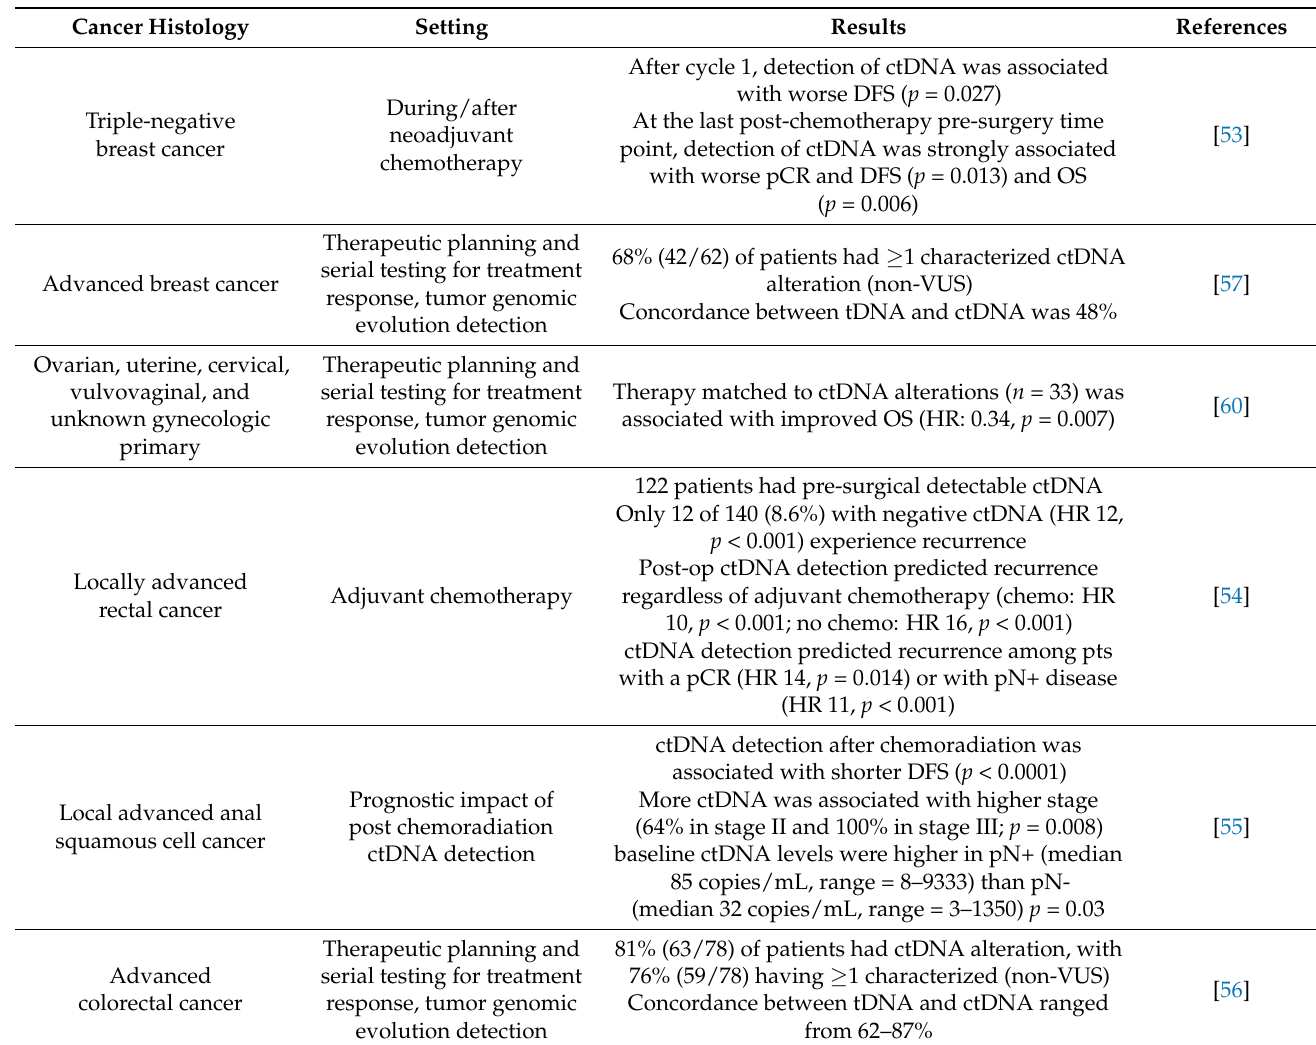
Table 3. Examples of studies investigating clinical applications of